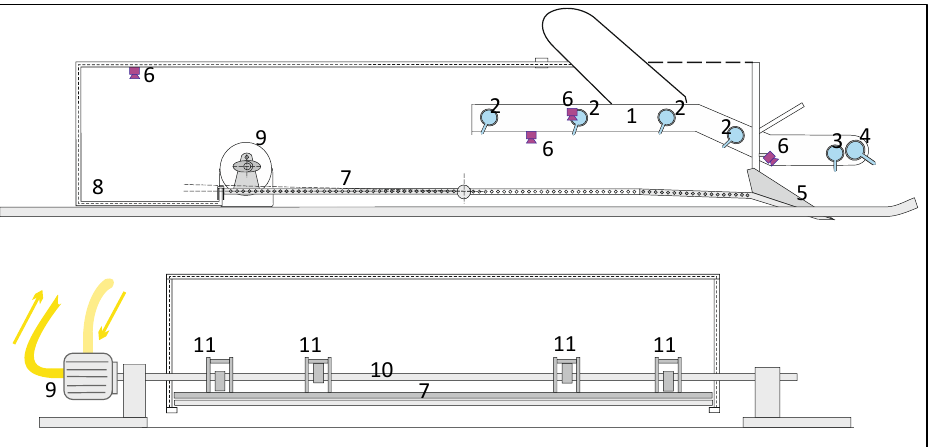
Figure 2. Schematic representation of the dredge prototype: side view (top) and rear view (bottom). (1) supply line of pressurized water; (2) transversal rows of nozzles, directing the water jets toward the cage bottom, favoring sand elimination; (3) transversal row of nozzles directing the water jets downward, favoring penetration of the front blade; (4) frontal row of nozzles providing forward, 45° inclined water jets, aimed at warning the vagile species; (5) front blade; (6) wireless underwater cameras; (7) oscillating section on the dredge bottom, hinged frontally to the fixed section; (8) clam storage basket on the rear end; (9) hydraulic motor; (10) camshaft; (11) pins integral to the oscillating section, for its lifting due to the cams action. Non-Scale representation due to the technical sketch without any picture scale.